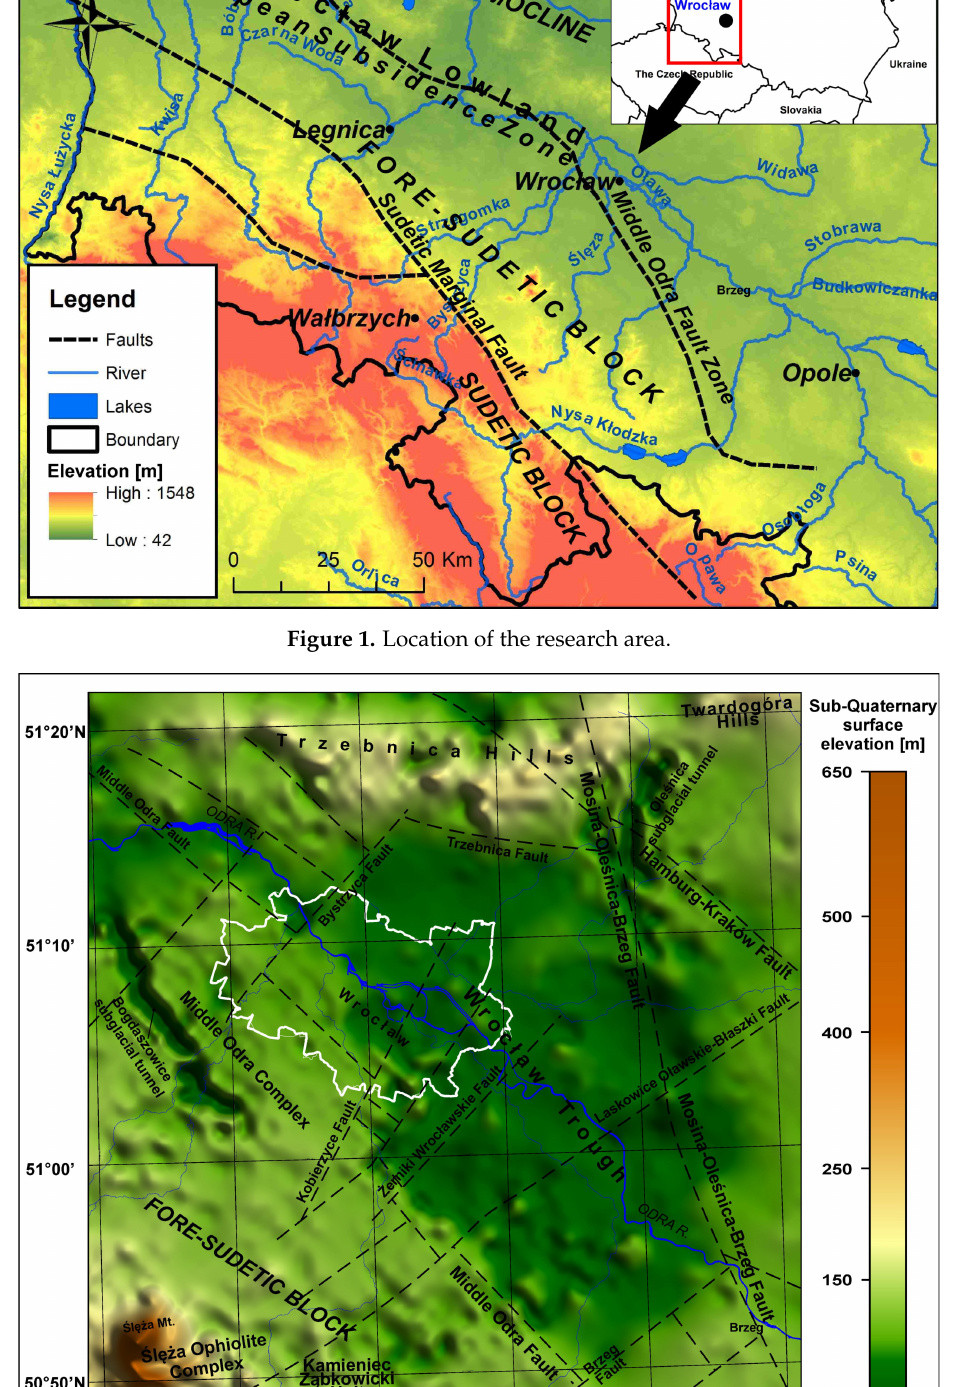
Figure 2. Sub-Quaternary topography with location of faults determined by Cymermann [29] and modified by Badura et al.